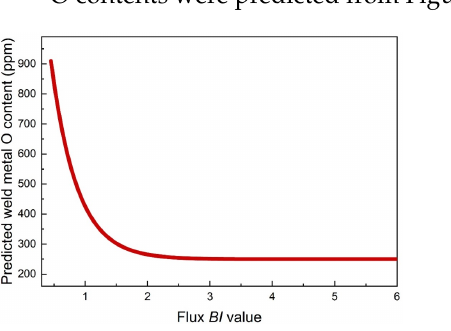
Appendix C. Prediction of O Content from Flux BI O contents were predicted from Figure A1 by using the flux BI values in Table 2.